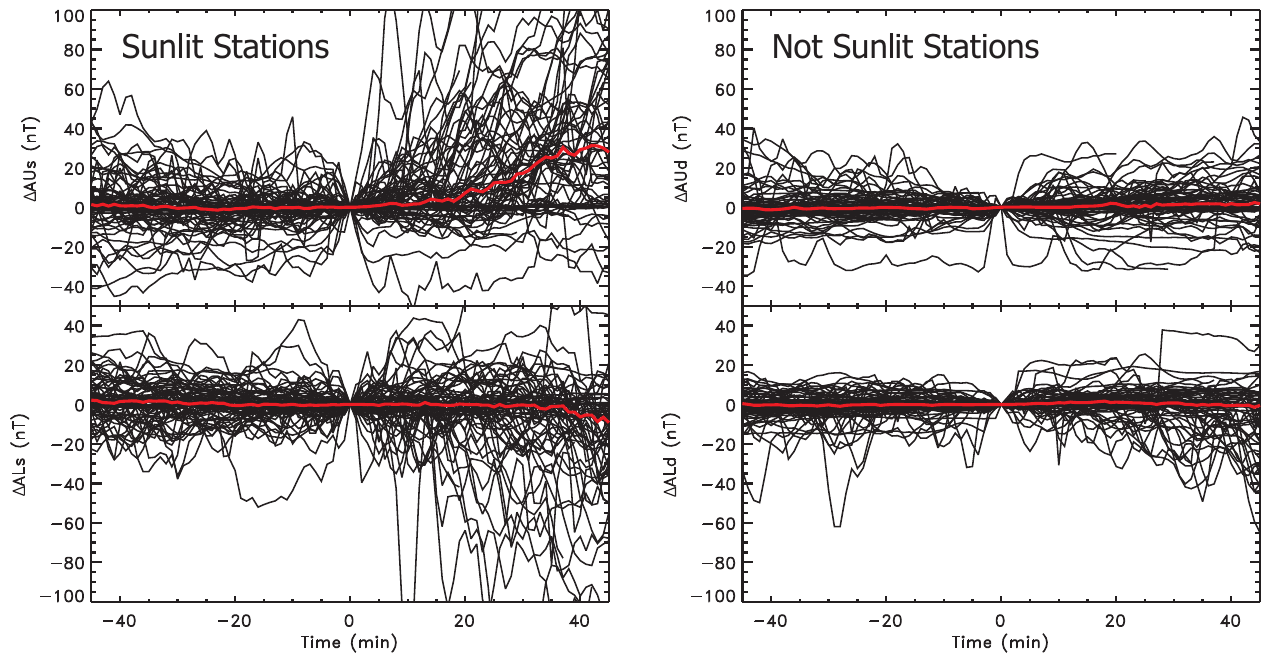
Figure 4 Fig. 4. Change of ALs/AUs and ALd/AUd from the time of the southward turning. The median is shown in